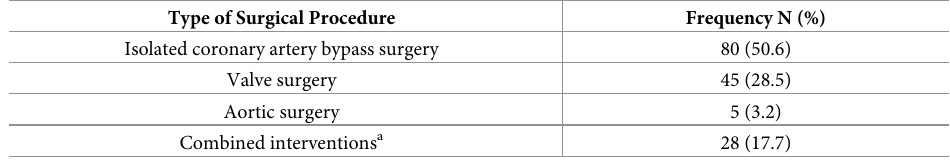
Table 2. Distribution of operative procedures in the whole population.